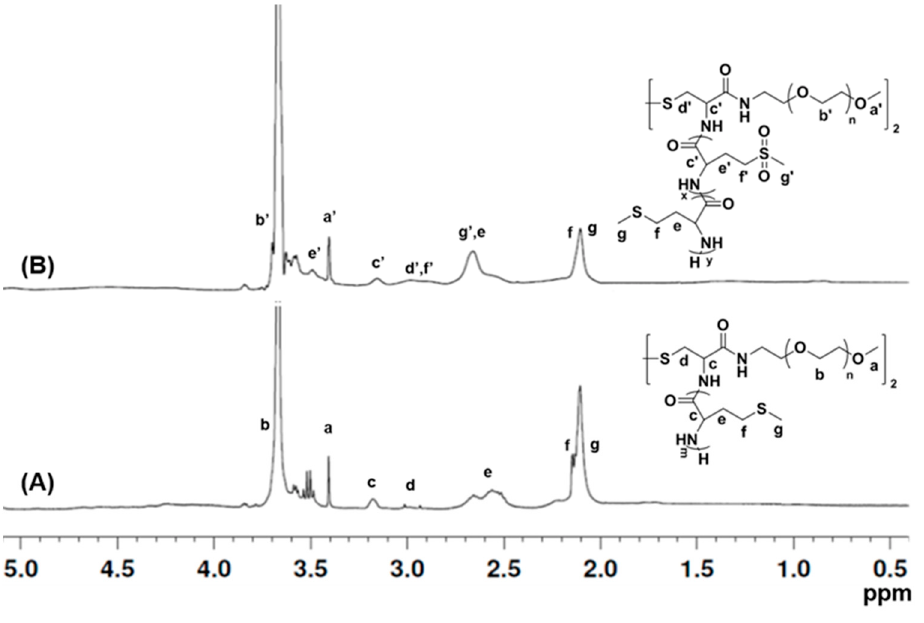
Figure 1. 1 H NMR spectra of gemini mPEG-Cys-PMT ( A ) and gemini mPEG-Cys-PMT oxidized in 0.1 mM H 2 O 2 for 12 h ( B ).